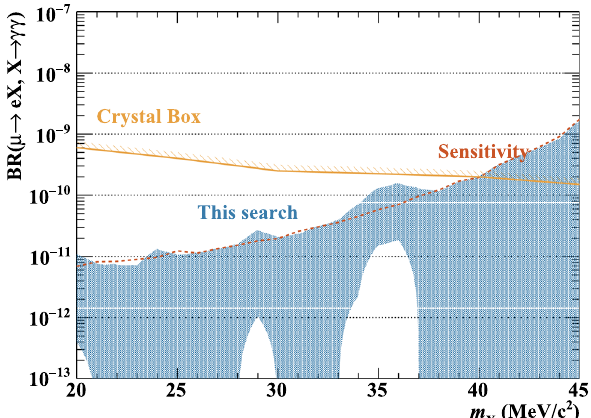
Fig. 17 Confidence intervals (90% C.L.) on B MEx2G (blue band) for τ = 20 ps. The red broken line shows the expected upper limits under X the null hypothesis and the yellow line shows the limits extracted by Crystal Box analysis